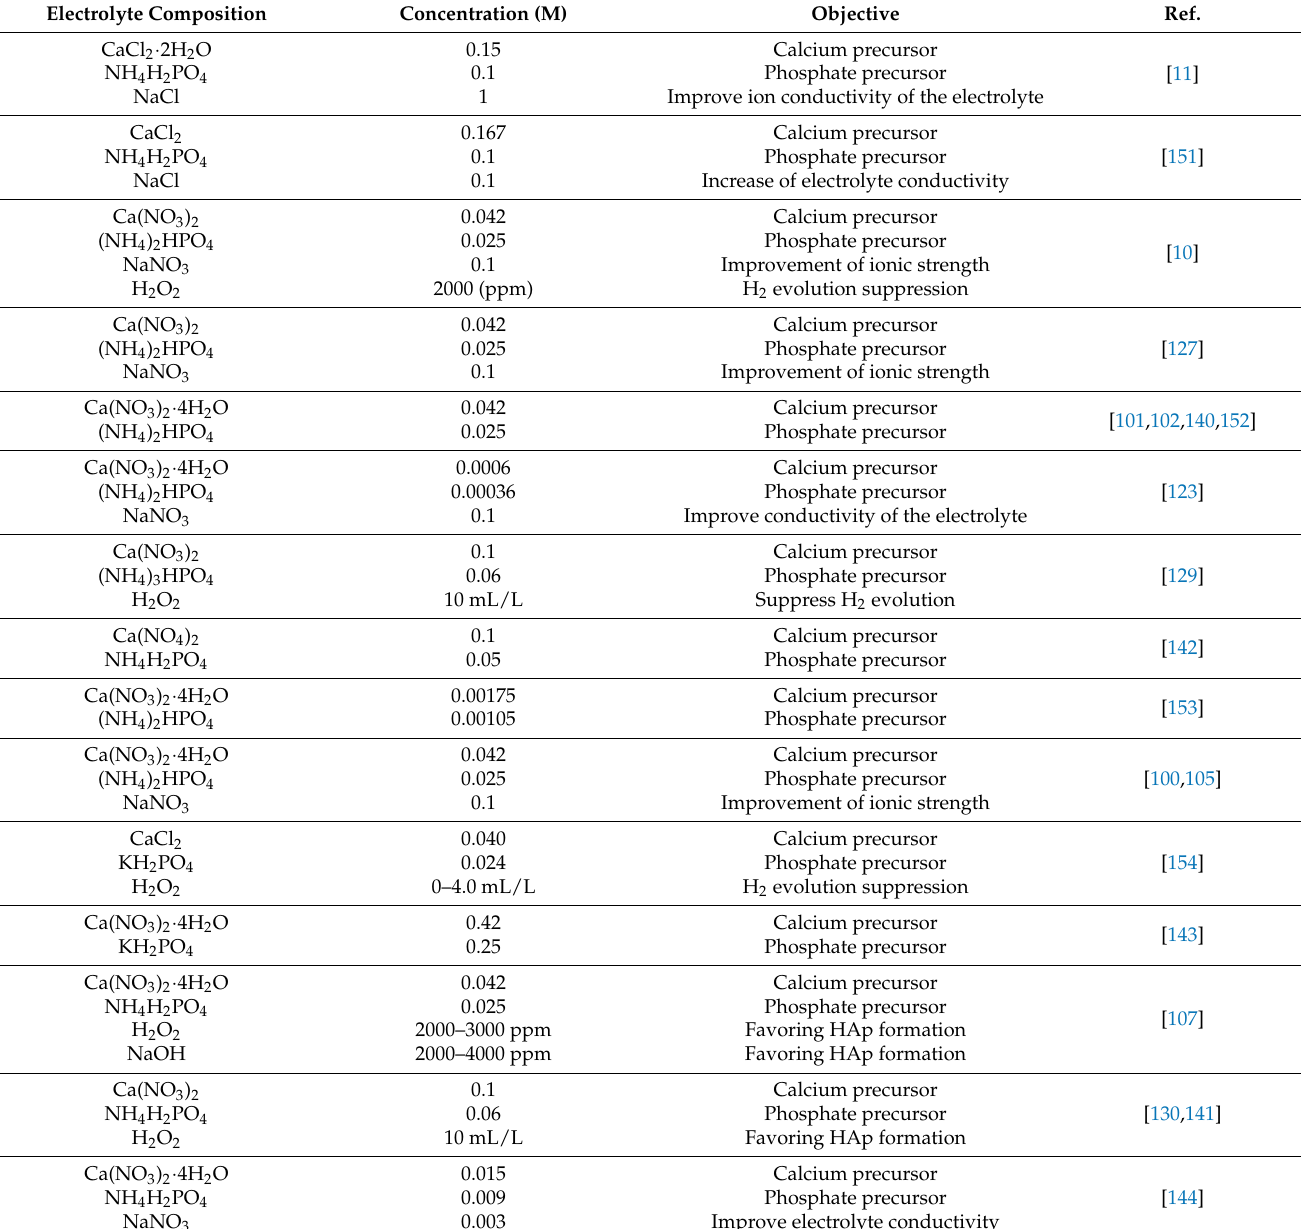
Table 4. Electrolyte composition and role of incorporated during electrodeposition of HAp coatings. Electrolyte Composition Objective